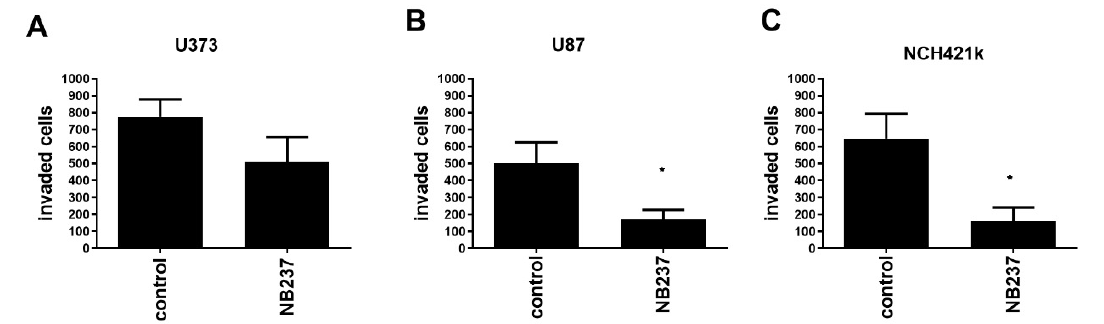
Figure 4. Effect of TRIM28 nanobody NB237 on invasion of GB cells. ( A , B ) GB cells, U373 and U87, at 10,000 cells/insert; and ( C ) GSCs NCH421k at 80,000 cells/insert, were seeded in the upper compartment in serum-free medium alone or in combination with TRIM28 nanobody (final concentration 100 µg/mL). The cells that invaded the Matrigel after 48 h were stained with 0.1% crystal violet and counted using inverted microscope. Each value represents mean ± S.D. (Three biological replicates). Statistical analyses was performed using GraphPad Prism software, using t -test, * p < 0.05, vs. control